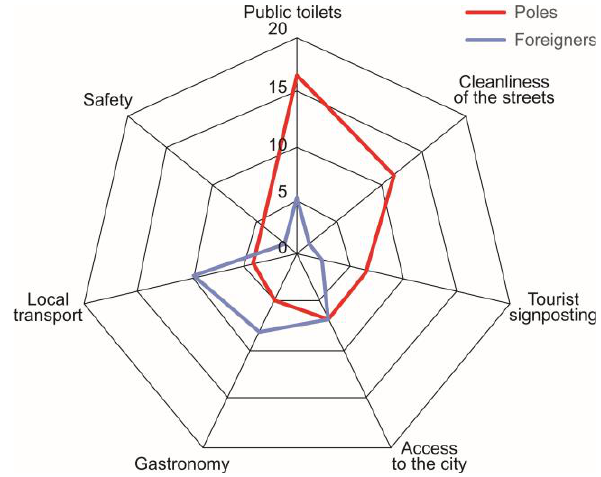
Figure 9. Lowest rated aspects of WYD in the Archdiocese of Lodz (the total of “bad” and “very bad”) (Source: authors, based on a